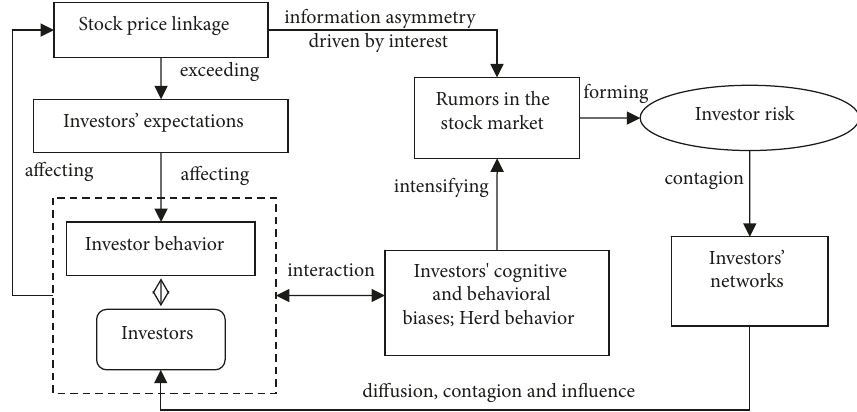
Figure 1: Mechanism analysis of investor risk formed by stock market rumors under the influence of price